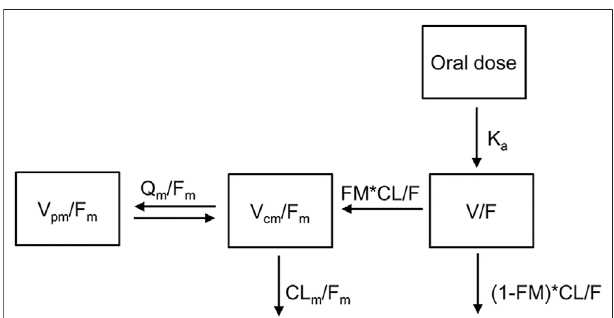
FIGURE 1 | Pharmacokinetic Model of Orally Administered TQ-B3101. CL/F: apparent clearance for TQ-B3101; CL m /F m :apparentclearance forTQ- B3101M; FM: fraction of TQ-B3101 metabolized to TQ-B3101M which was fi xed to one in the model; K a : absorption rate constant for TQ-B3101; Q m /F m : apparent inter-compartmental clearance for TQ-B3101M; V/F: apparent volume of distribution for TQ-B3101; V cm /F m : apparent volume